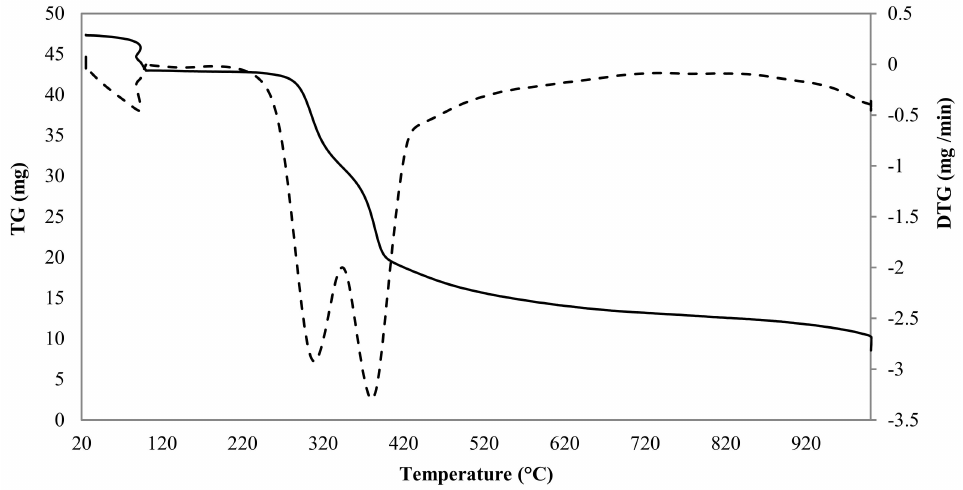
Figure 1. Mass loss and rate of mass loss profiles for CNS. The solid line corresponds to the thermogravimetric (TG) curve and the dashed line represents the derivative of the curve